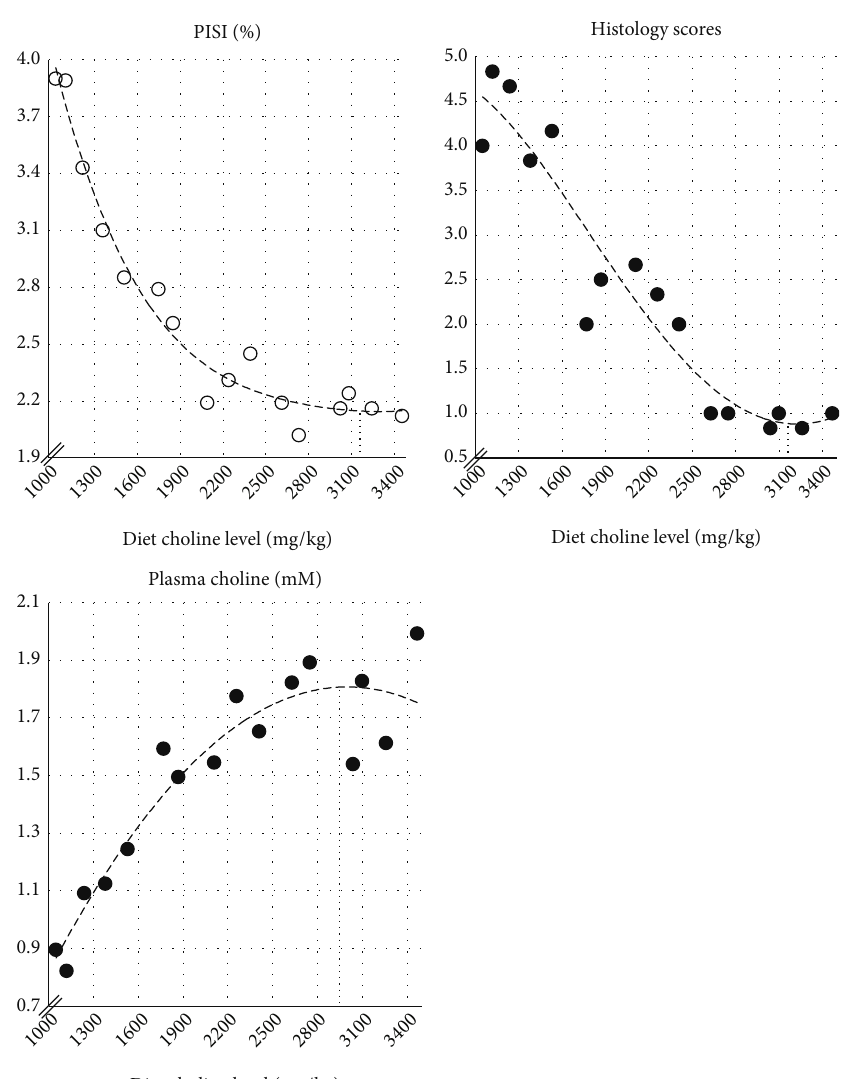
Figure 18: Relationship between diet choline level and relative weight (%) of PI (PISI), average sum of histological scores (Normal=1, Mild=2, Moderate =3, Marked=4, Severe =5), and total plasma choline level (mM) as indicated by the polynomes best fi tting the observations. Visual examination of the trend line for the histoscores indicates an average choline requirement of about 3200mg/kg, based on the PISI and histological scores, and about 3000 mg/kg based on the plasma choline